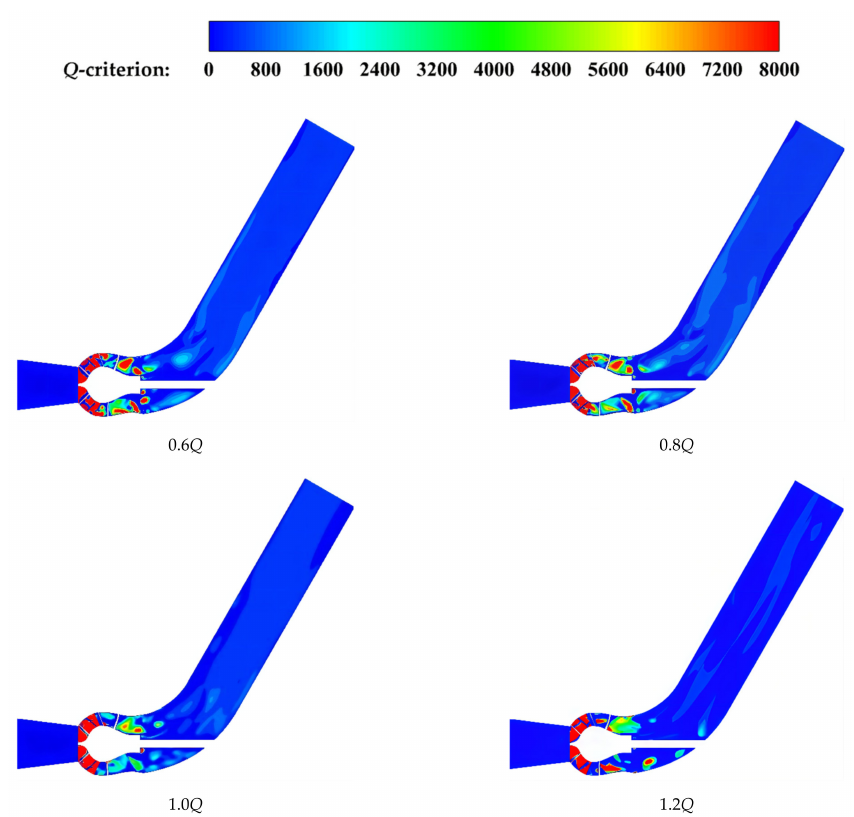
Figure 9. Vorticity distributions under different flow rate